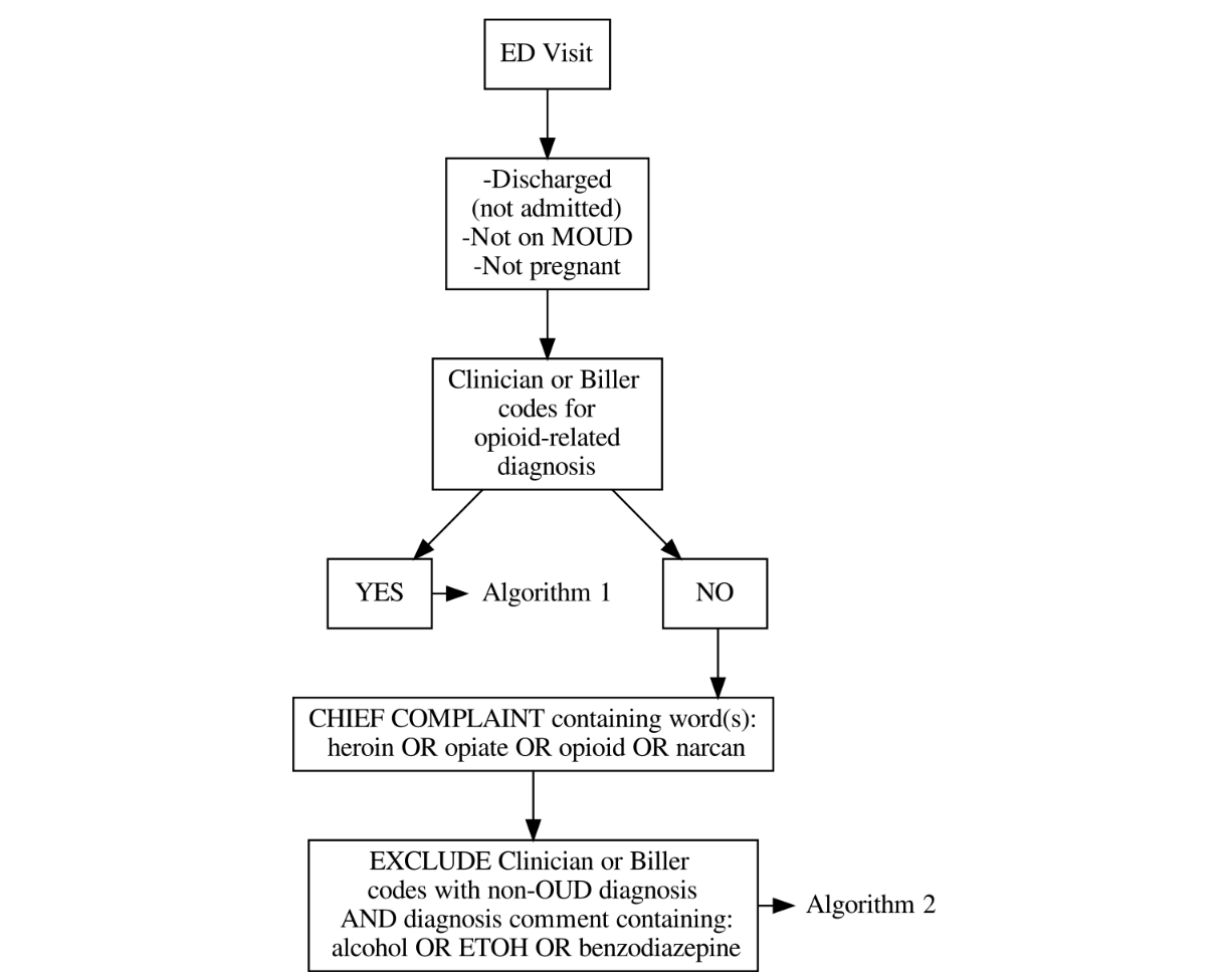
Figure 1. Flow diagram of phenotypes. ED: emergency department; MOUD: medication for opioid use disorder; ETOH: ethyl alcohol; OUD: opioid use disorder.